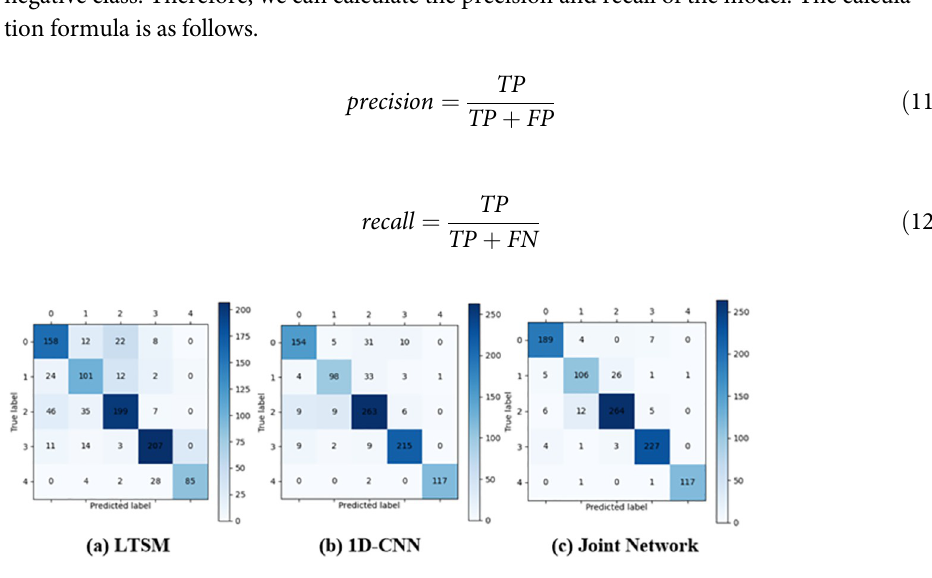
Fig 8. Confusion matrices for three networks. (a) LTSM; (b) 1D-CNN; (c) Joint Network.